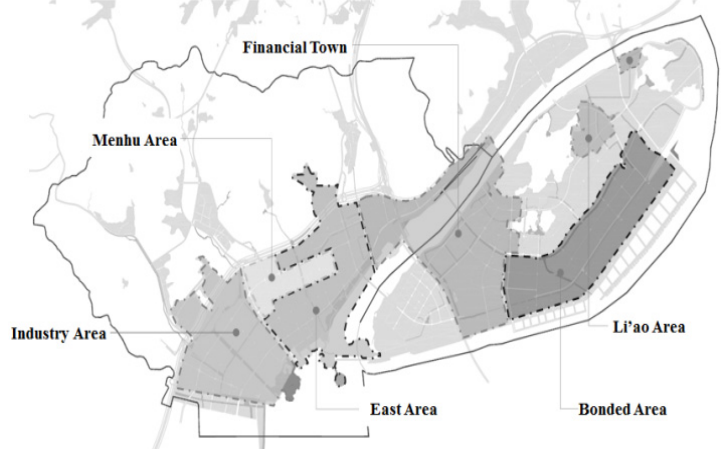
Figure 4. The planning areas.